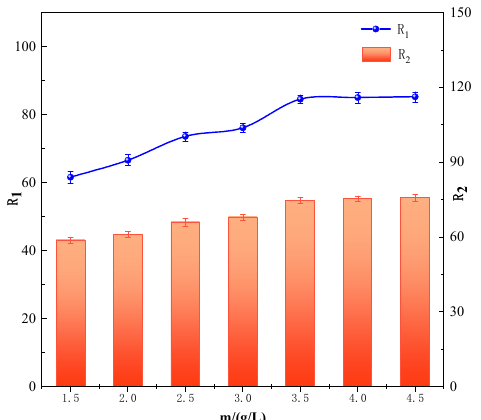
Figure 4. Effect of manganese sand dosage on the iron and manganese ion removal. R 1 is the iron ion removal rate; R 2 is the manganese ion removal rate.